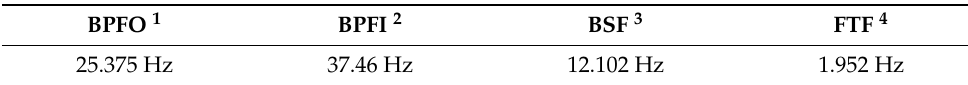
Table 2. Bearing Fault Feature Frequencies at 290